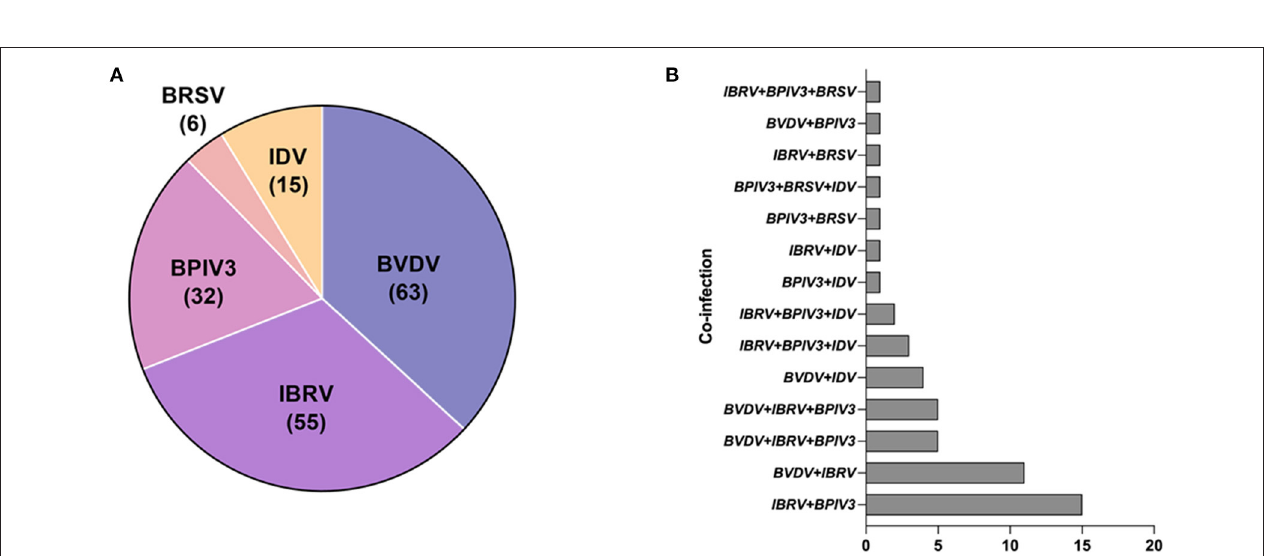
FIGURE 5 | Clinical sample detection: (A) The distribution of clinical samples that are positive for BVDV, BoHV-1, BPIV3, BRSV or IDV. (B) The co-infection incidence among BVDV, IBRV, BPIV3, BRSV and IDV.